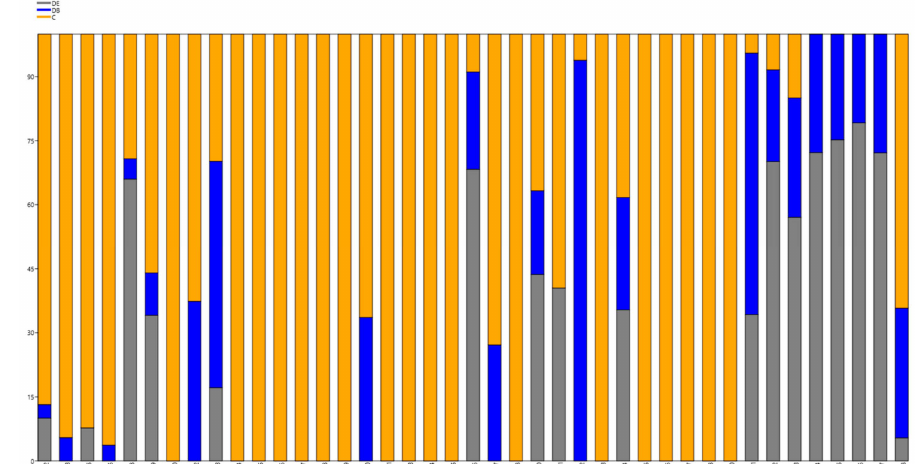
Figure 4. Stacked chart of normalized read counts per treatments DE, DB, and C. The plot was generated based on CLC Genomics Workbench normalized reads, generating novel small matured RNAs, and depicted using PAST version 3.25. The numbers on axis X correspond to Table 2, column miRNA name. Percentages are depicted on axis